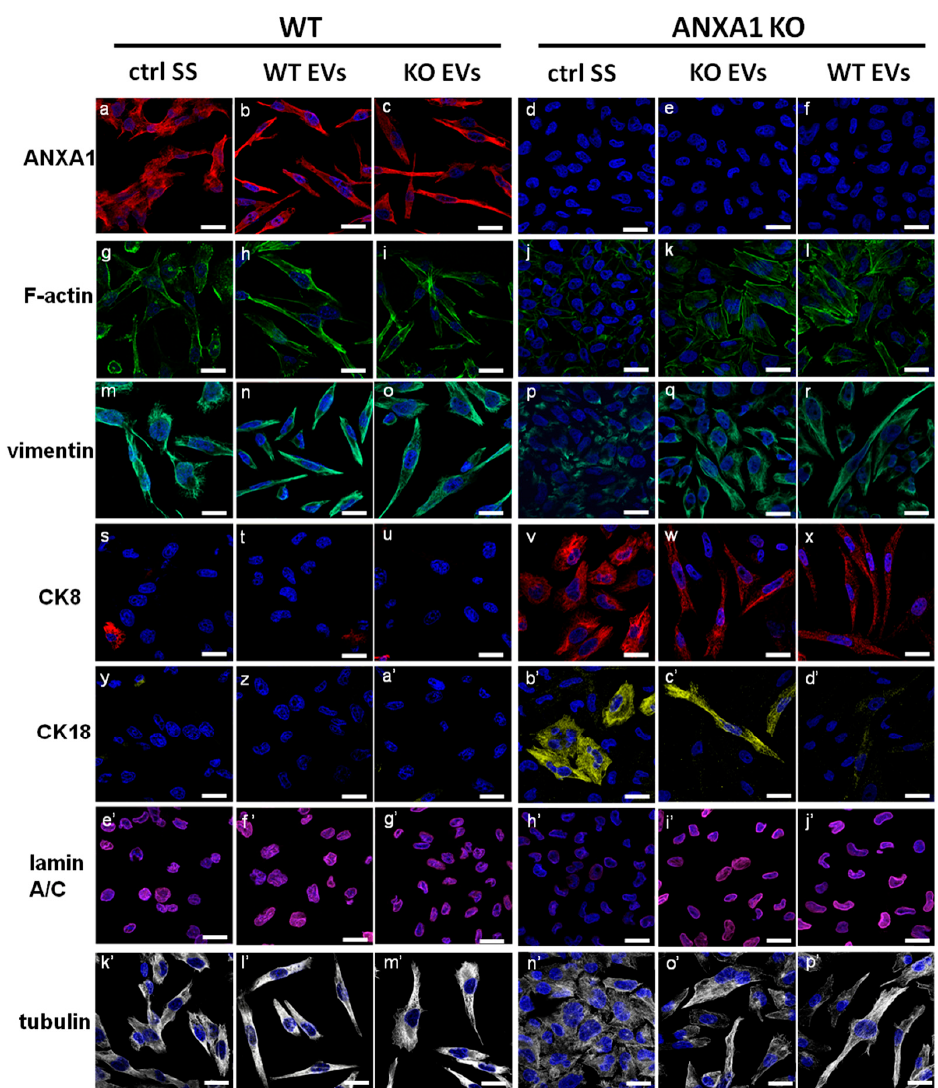
Figure 3. Evaluation of the main Epithelial to Mesenchymal Transition (EMT) markers on WT and ANXA1 KO MIA PaCa-2 cells in presence of EVs. Immunofluorescence analysis to detect: ANXA1 (panels a – c for WT and d–f for ANXA1 KO cells), F-actin (panels g – i for WT and j – l for ANXA1 KO), vimentin (panels m – o for WT and p – r for ANXA1 KO cells), CK8 (panels s – u for WT and v – x for ANXA1 KO cells), CK18 (panels y , z , a’ for WT and b’ – d’ for ANXA1 KO cells), lamin A/C (panels e’ – g’ for WT and h’ – j’ for ANXA1 KO cells) and tubulin (panels k’ – m’ for WT and n’ – p’ for ANXA1 KO cells) on WT and ANXA1 KO MIA PaCa-2 cells, treated or not with EVs released from both cell lines. Nuclei were stained with Hoechst 33342 1:1000 for 30 min at room temperature (RT) in the dark. Magnification 63 × 1.4 numerical aperture (NA). Bar = 10 µ